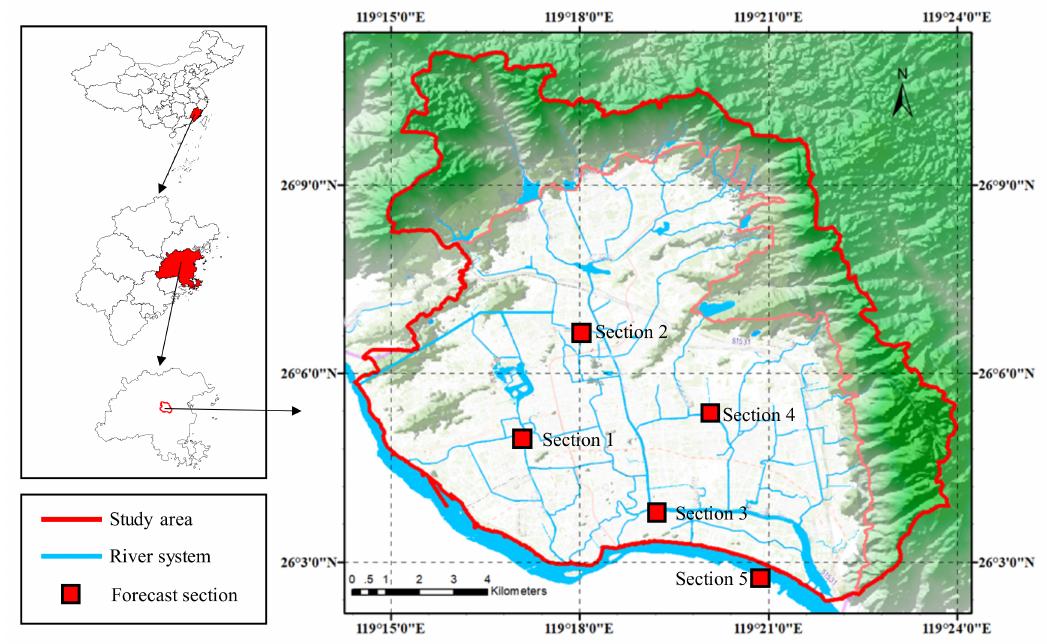
Figure 1. Distribution of the river system and river gauges in Fuzhou